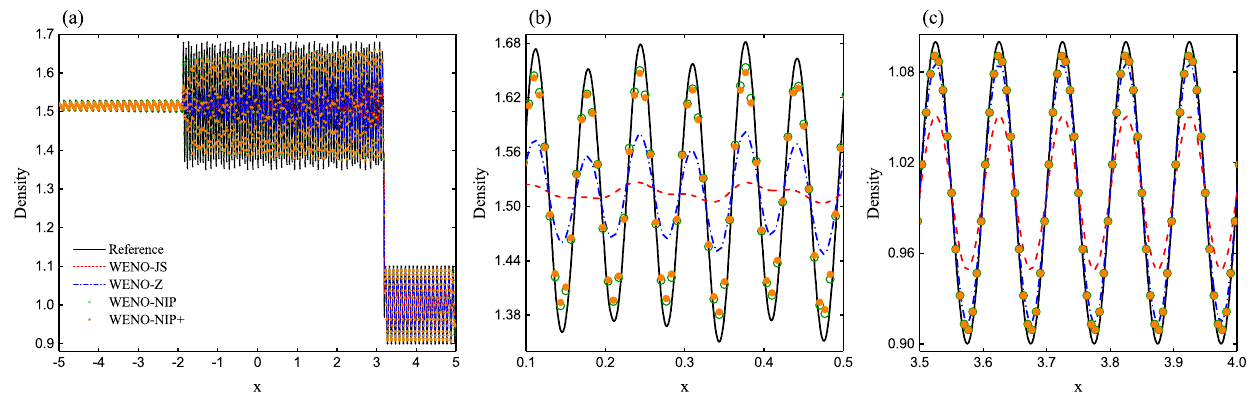
At x = 0 and x = 1 , the reflective boundary conditions are used. It is run with N = 600 uniform cells until t = 0.038 .